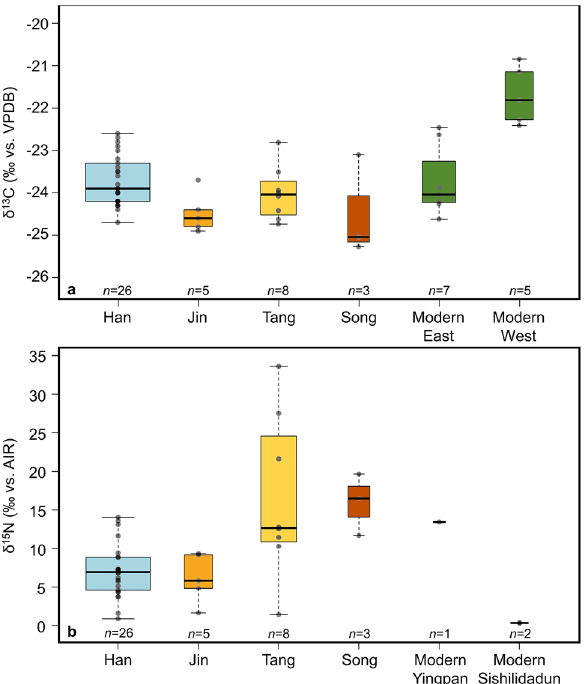
Figure 7. Bulk isotope data box plots by age. ( a ) Han (Sites 1–7), Jin (Sites 9 and 10), Tang (Sites 11 and 12), and Song (Site 14) δ 13 C data from Great Wall Phragmites . Modern data includes all extant P. australis separated into eastern and western clusters. ( b ) Han, Jin, Tang, and Song δ 15 N data from Great Wall Phragmites and modern P. australis from Sites 10 and 14. The thick black lines show the mean values from each period, while the widths of the boxes are proportional to the square-roots of the number of observations.